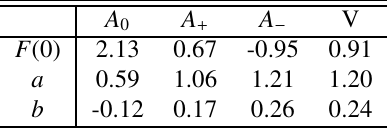
Table 2: Parameters of double pole parametrization Eq. (4) for the form factor A 0 A + A